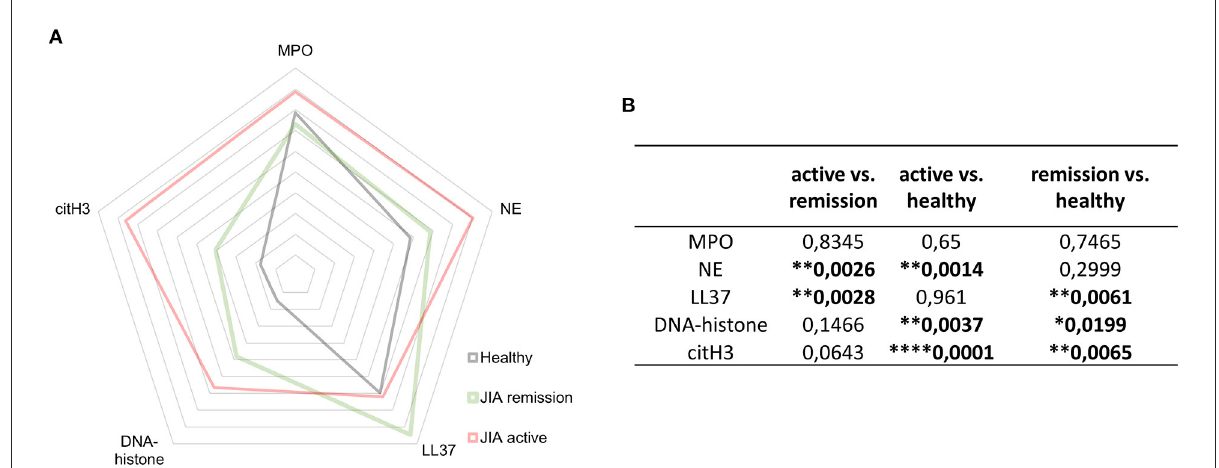
FIGURE5 NETosis- related products. (A) Detection of NET-related products myeloperoxidase (MPO), neutrophil elastase (NE), LL37, DNA-histone complexes, and citH3 in JIA active ( n = 10), JIA remission ( n = 10), and healthy donors ( n = 26) using ELISA. (B) Table containing p-values related to NET-associated products in JIA active ( n = 10), JIA remission ( n = 10), and healthy donors ( n = 26) detected using ELISAs. Values are standardized and expressed as median values. Statistical analyses were performed using unpaired t -tests. Values of p < 0.05 (*), p < 0.01 (**), p < 0.001 (***), and p < 0.0001 (****) were considered statistically significant.